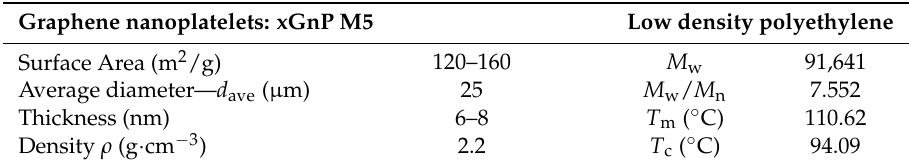
Table 1. Basic characteristics of the low-density polyethylene and GnP nanoplatelets as a filler. Graphene nanoplatelets: xGnP